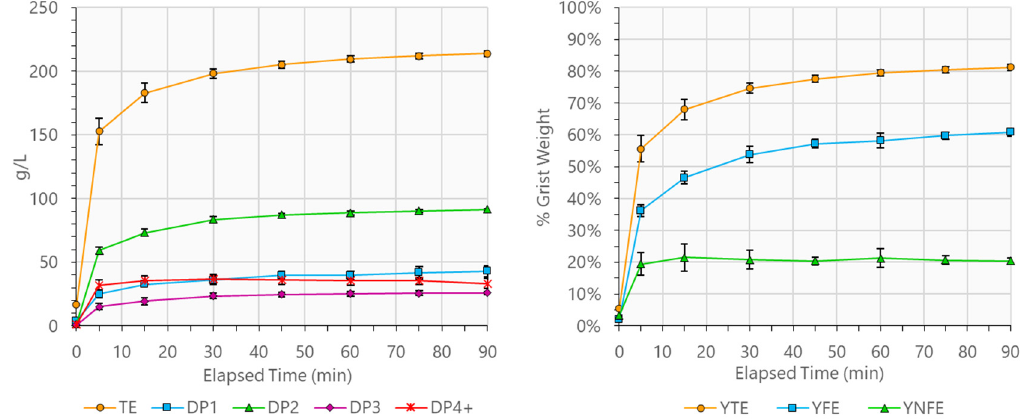
Figure 1. Time-course kinetics of starch conversion for the center point condition (C00, n = 6). Left : Time-course concentration profiles of total extract (TE), glucose and fructose (DP1), maltose (DP2), maltotriose (DP3), and DP4 + carbohydrates. Right : Time-course profiles of total (Y TE ), fermentable (Y FE ), and nonfermentable (Y FNE ) extract yields as a % of grist weight. Errors bars represent one standard deviation.